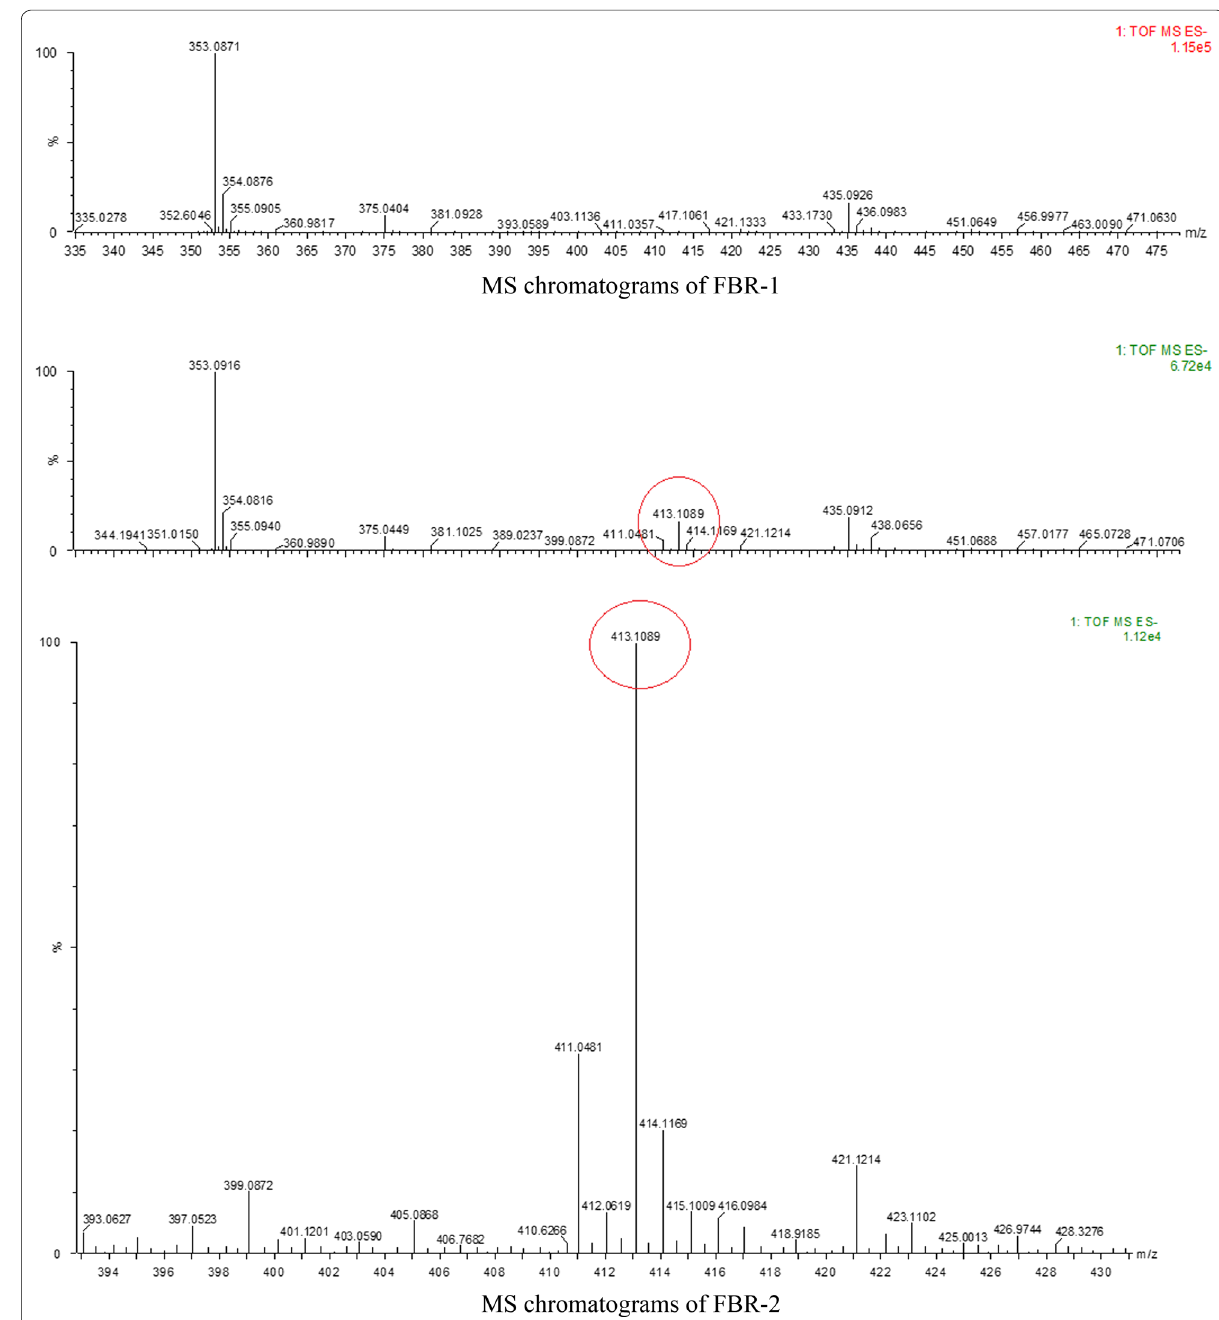
Fig. 3 MS chromatograms of compound PBR-1 and PBR-2, the red circle in PBR-2 show m/z 413 (M